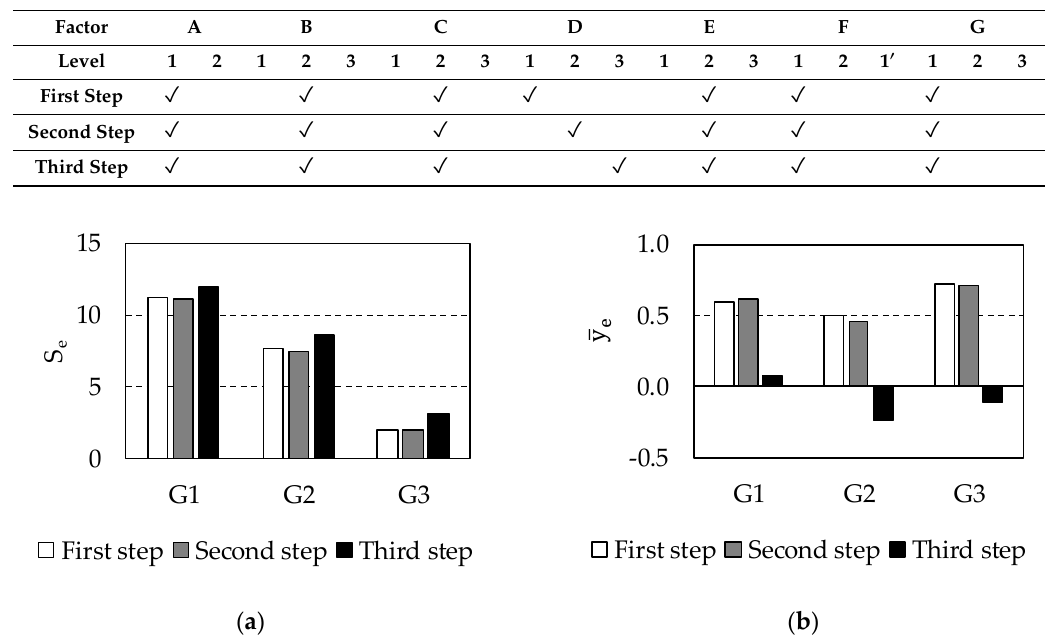
Figure 5. Confirmation of prediction accuracy at each step of fitting: ( a ) residual sum of squares S e and ( b ) average deviation y e